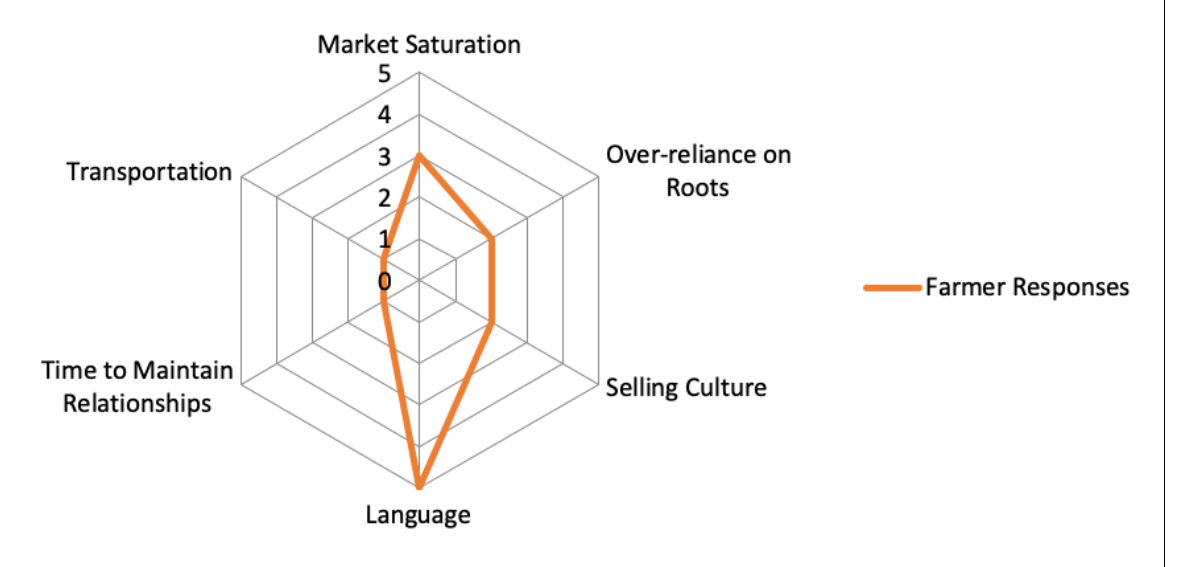
Figure 2. Farmer-Identified Selling